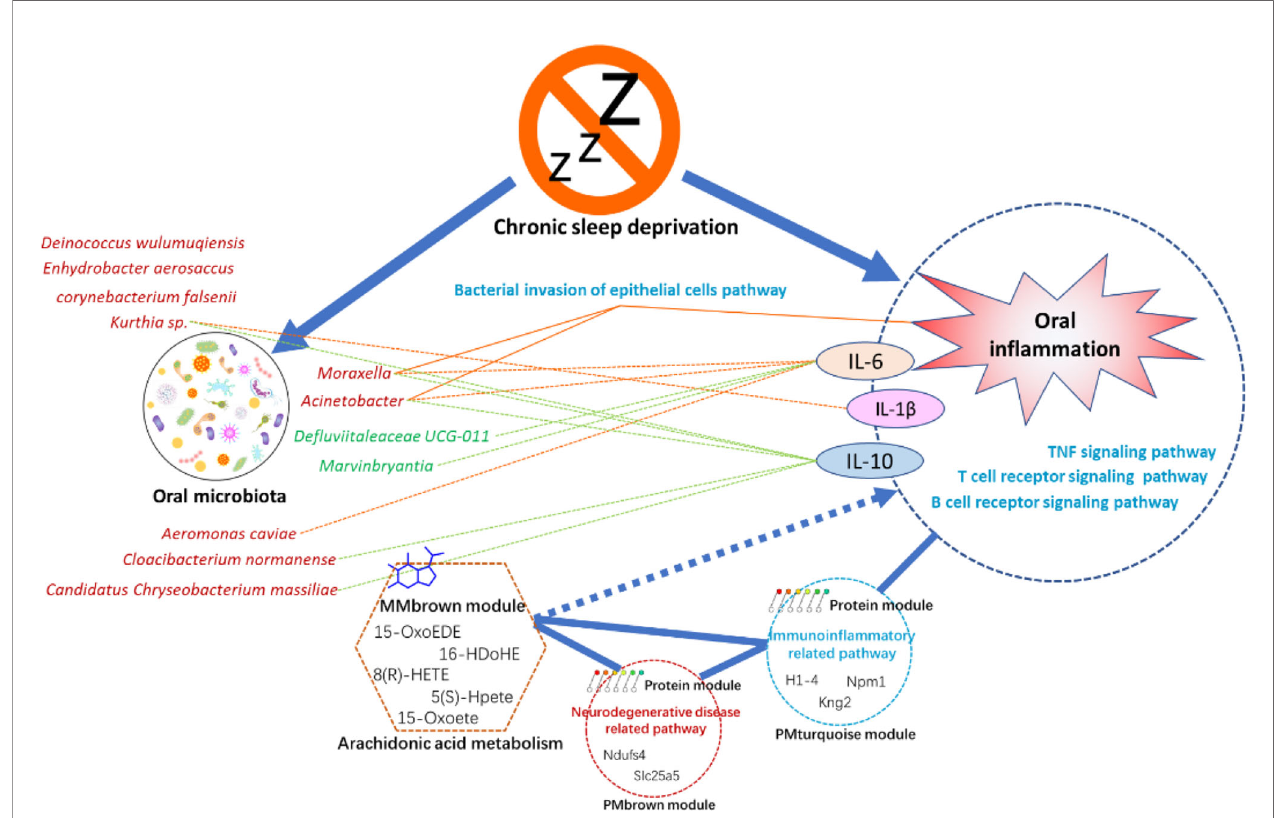
FIGURE 9 | Summaries of the major relationships between CSD and oral